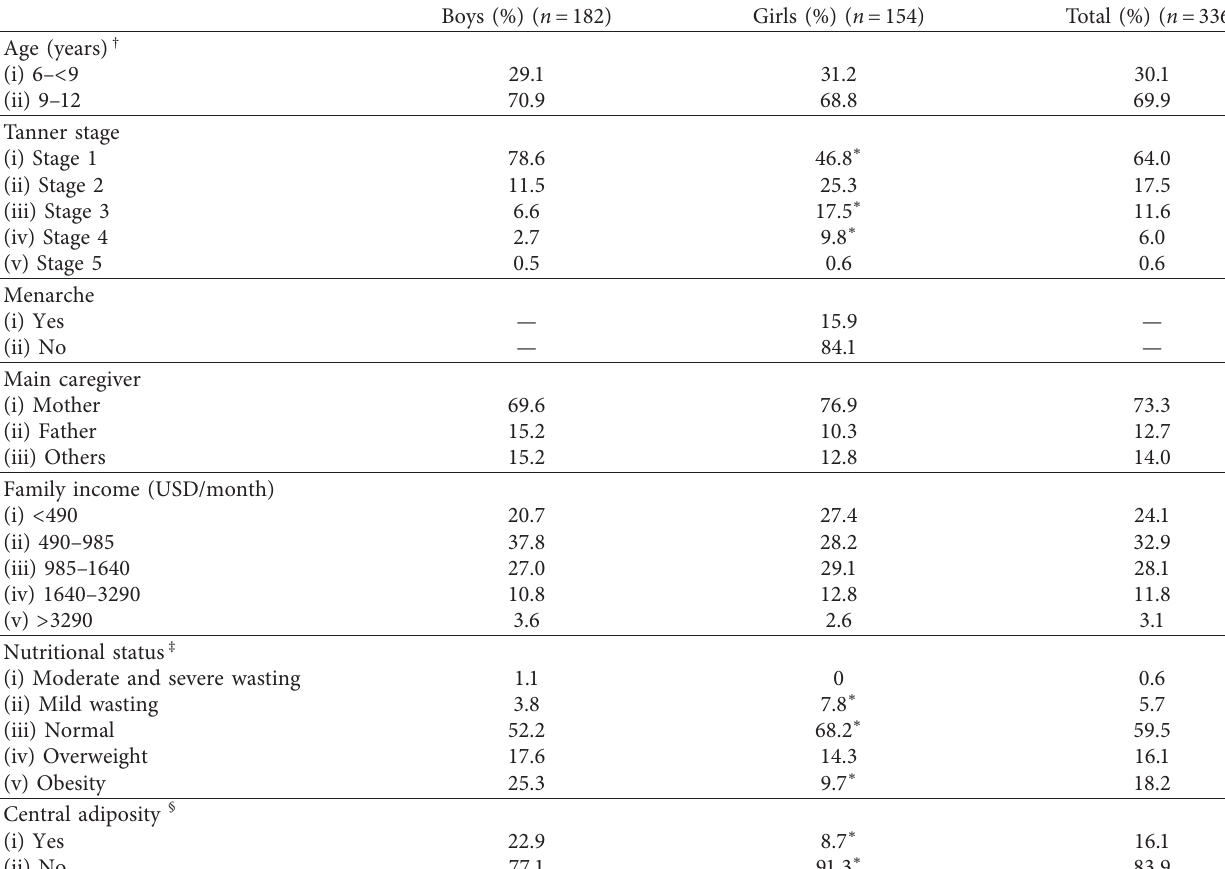
Table 1: Characteristics of the study participants.